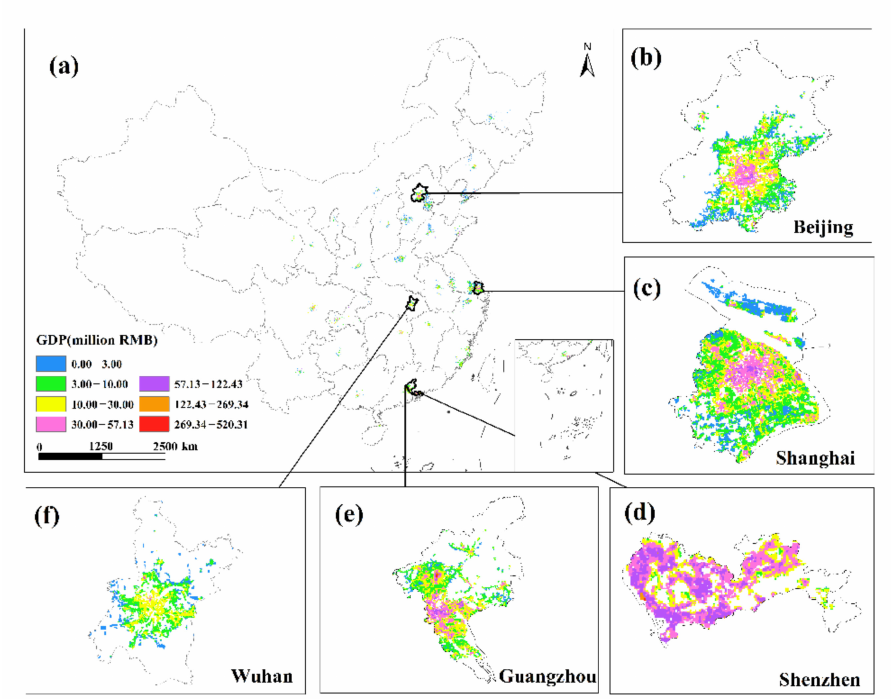
Figure 8. The spatial distribution of the total GDP of the secondary and tertiary industries in January 2020. ( a ) The spatial distribution of the total GDP in 34 Chinese cities; ( b ) Beijing; ( c ) Shanghai; ( d ) Shenzhen; ( e ) Guangzhou; ( f ) Wuhan.